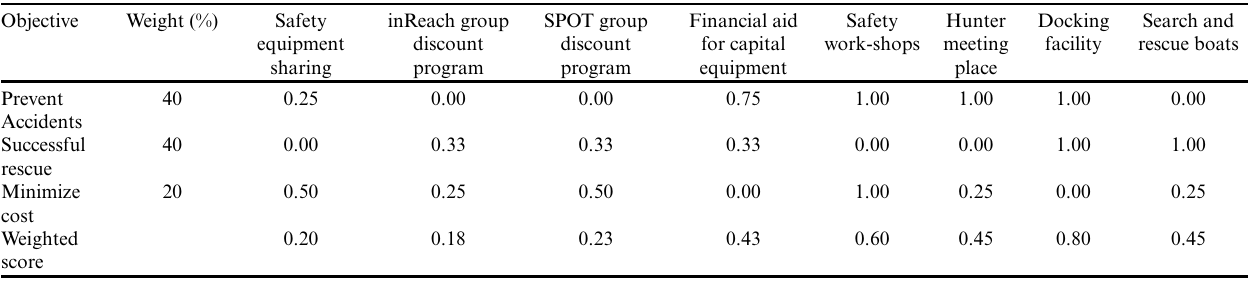
Table 2 . Structured decision analysis consequence table evaluating how different safety alternatives meet predefined objectives (workshop 3). Each objective was assigned a weight by the participants, based on its relative importance. Participants identified potential strategies, and evaluated each strategy in terms of its ability to meet the objectives. Safety strategies were ranked as having “no,” “low,” “moderate,” “high,” or a “very high” chance of meeting each objective. Categorical responses were scaled to numerical values between 0 (no effect on objective) to 1 (very high probability of meeting objective). For the cost objective, a score of 0 = very expensive and 1 = inexpensive. Scaling was done with the formula: (score – worst score)/(best score – worst score) for each row (Gregory et al. 2012). Scores were multiplied by the predefined weightings assigned by the participants (see above), and a total score was calculated based on the sum of the three scores for each safety strategy alternative. This consequence table was evaluated by seven